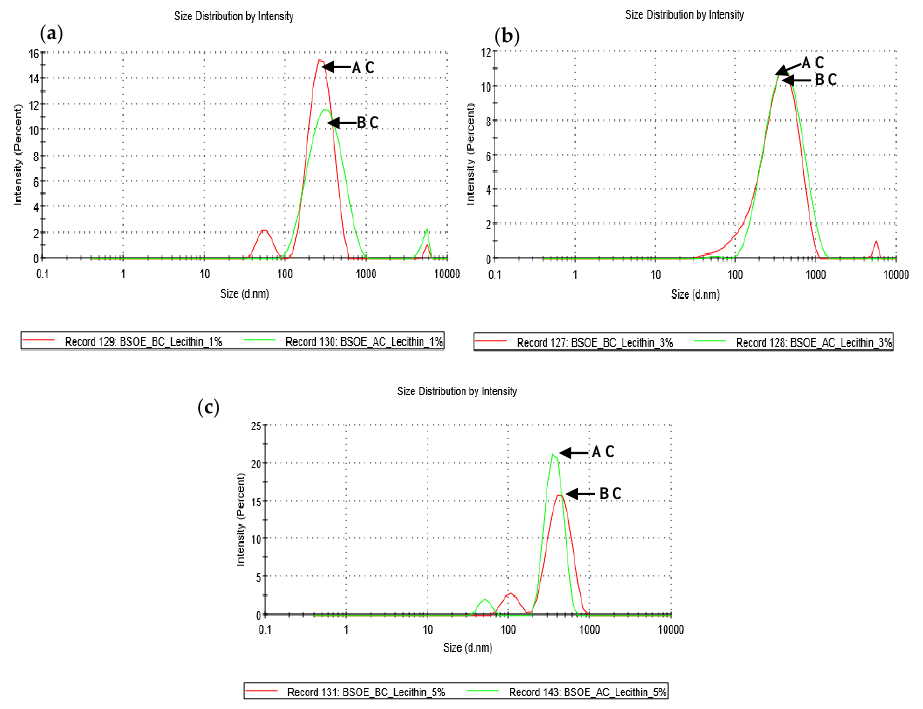
Figure 2. Effect of ( a ) 1% w / v ( b ) 3% w / v and ( c ) 5% w / v lecithin concentrations on particle size distributions of freshly prepared and centrifuged alginate-BSO emulsion. BC = before centrifuge, AC = after centrifuge, n =